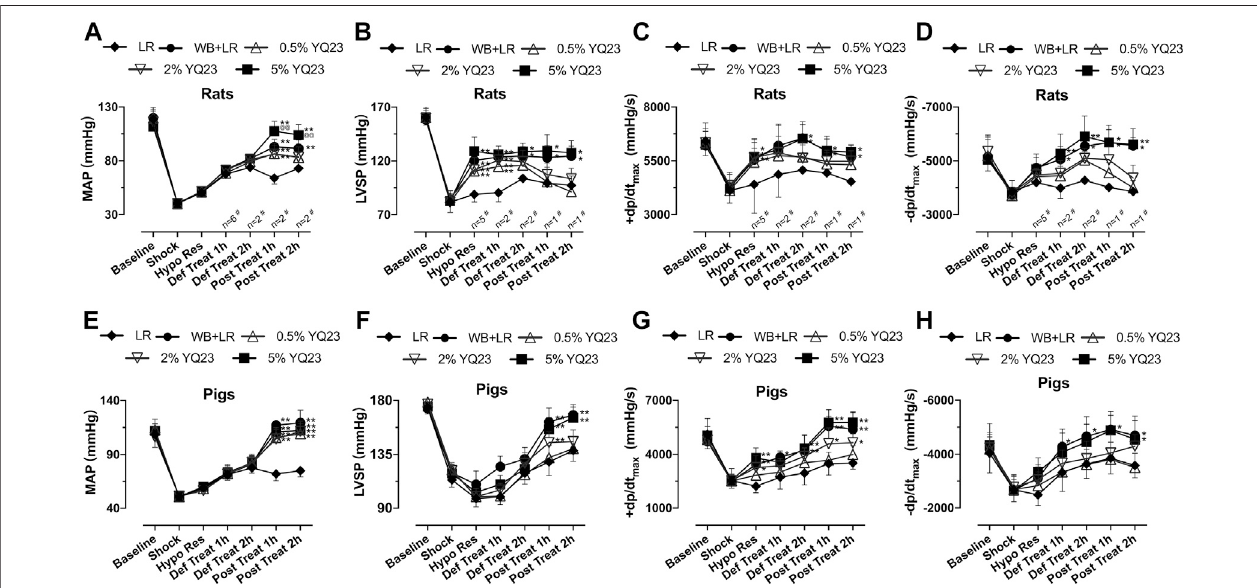
FIGURE 3 | YQ23 restored hemodynamics following uncontrolled hemorrhagic shock in rats and pigs. (A) , MAP in rats ( n (cid:1) 16/group unless otherwise annotated); (B) , LVSP in rats ( n (cid:1) 10/group unless otherwise annotated); (C,D) , ± dp/dt max in rats ( n (cid:1) 10/group unless otherwise annotated); (E) , MAP in pigs ( n (cid:1) 6/ group); (F) , LVSP in pigs ( n (cid:1) 6/group); (G,H) , ± dp/dt max in pigs ( n (cid:1) 6/group). MAP, mean arterial pressure; LVSP, left ventricular systolic pressure; ± dp/dt max , maximal rateoftheincreaseordecreaseofleftventricularpressure;LR,LactateRinger ’ ssolution;WB,wholeblood.* p < 0.05v.s.LRatthesametimepoint,** p < 0.01v.s. LR at the same time point, @ p < 0.05 v. s. WB + LR at the same time point, @@ p < 0.01 v. s. WB + LR at the same time